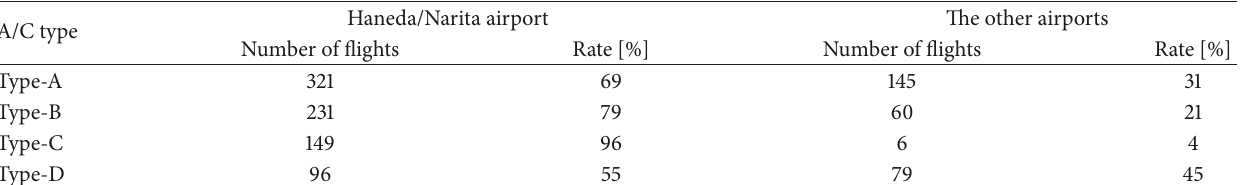
Table 3: Number of flights per aircraft type.